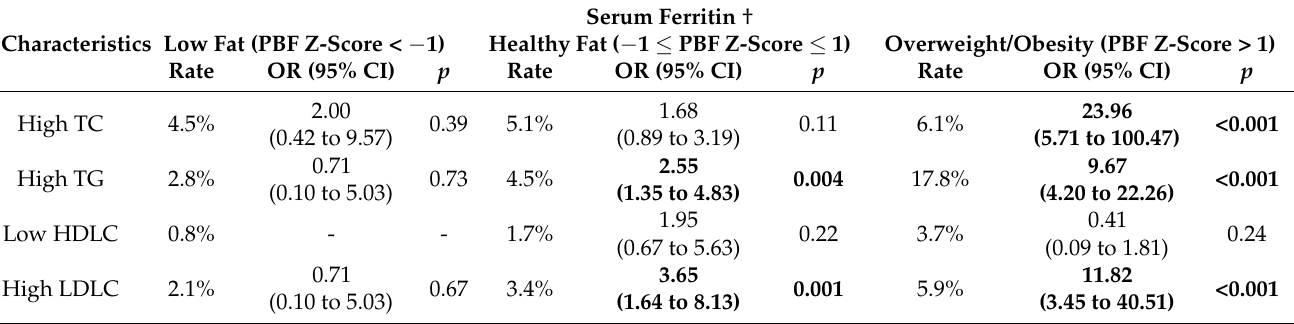
Table 3. Adjusted linear regression analysis of relationship between serum ferritin and lipid abnor- mality parameters among participants with different PBF